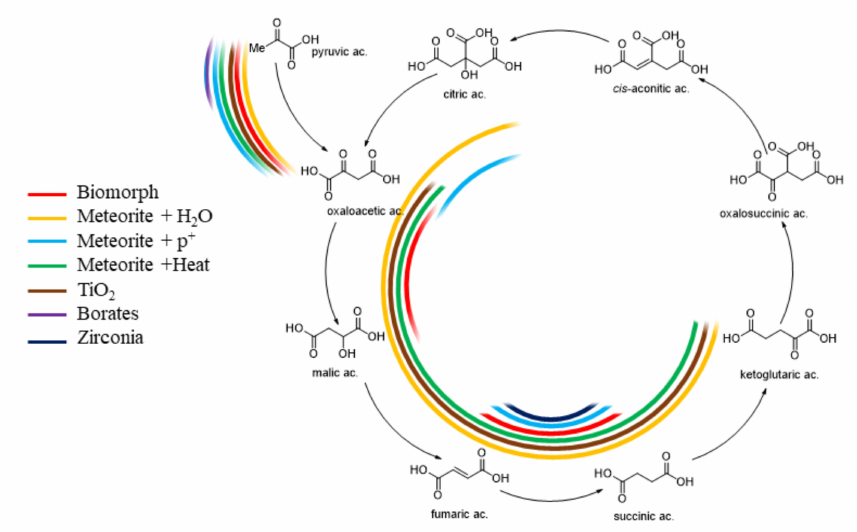
Figure 1. Krebs cycle intermediates produced from HCONH 2 and minerals. The color code provides the carboxylic acids that are synthesized in the presence of the reported mineral and energy source. The following references are associated to the color code description of the reactions: (i) red [54,56]; (ii) yellow [57]; (iii) azure [53]; green [51,52]; purple [50]; and dark blue